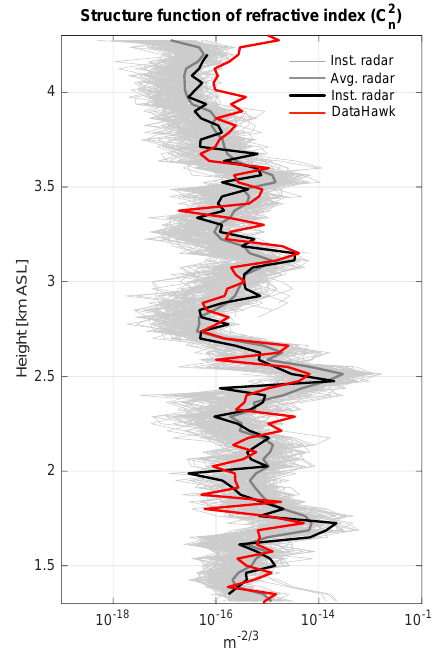
Figure 14. Similar to Fig. 8 but during the afternoon flight (15:21– 15:46), which only had a descent